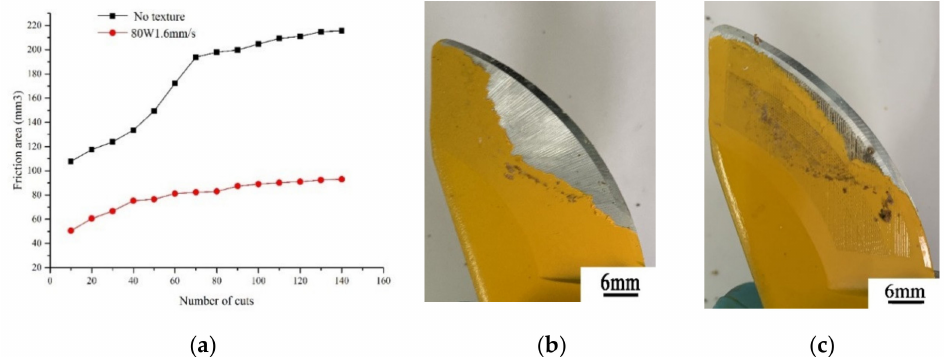
Figure 26. Shear test on the 20 mm-diameter branch: ( a ) relationship between worn area and number of cuts; painted worn area. ( b ) Non-textured pruner, ( c ) textured pruner at the power of 80 W and speed of 1.6 mm /